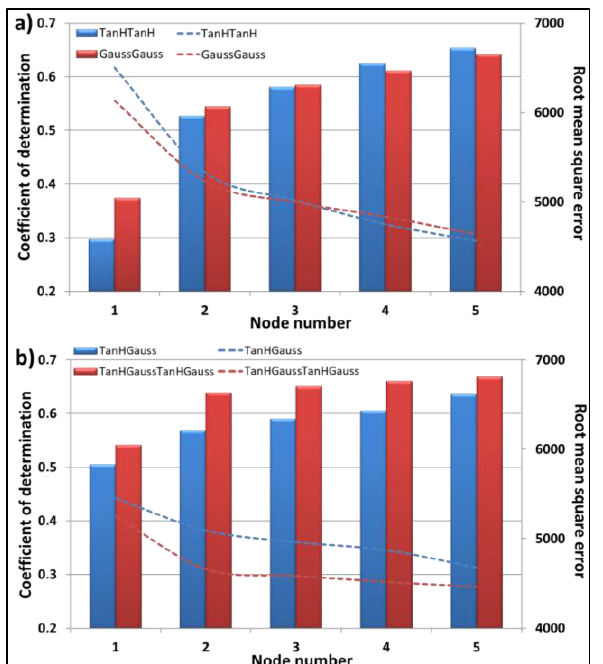
Figure 7 . Scatterplot of the observed test versus best predicted Figure 5 . Barplots of the neural network models’ test results for infrared (a) two hidden layers ranging for separate TanH and Gauss functions; and (b) two hidden layers for combined TanH and Gauss functions.